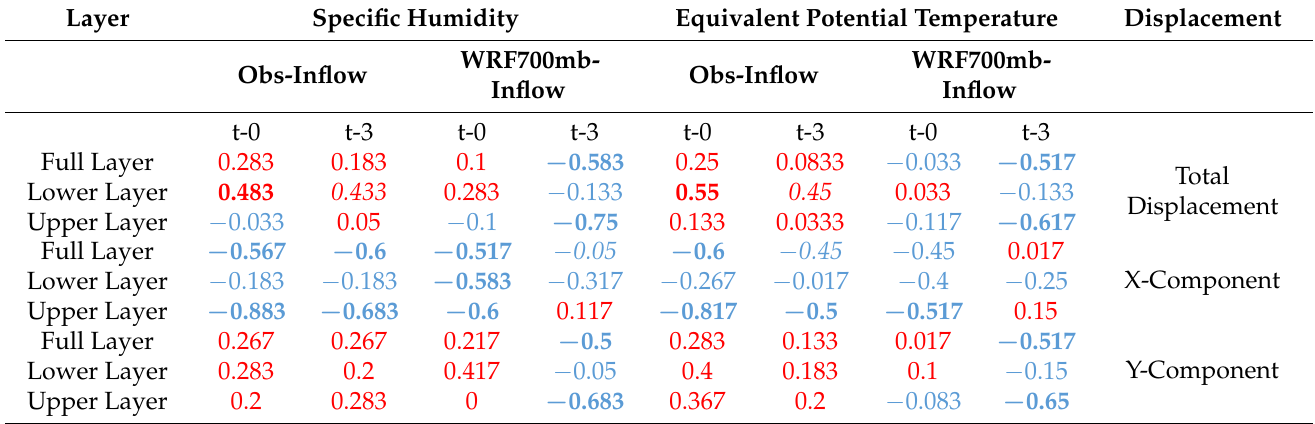
Table 4. As in Table 2 except for Type A cases.